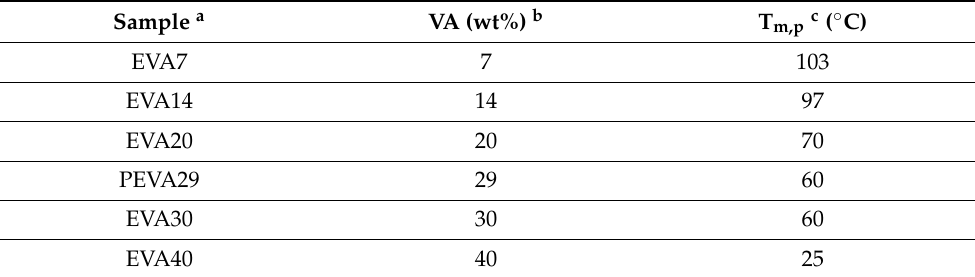
Table 2. Effect of VA content on the melting point of polyethylene-vinyl acetate [21]. Sample